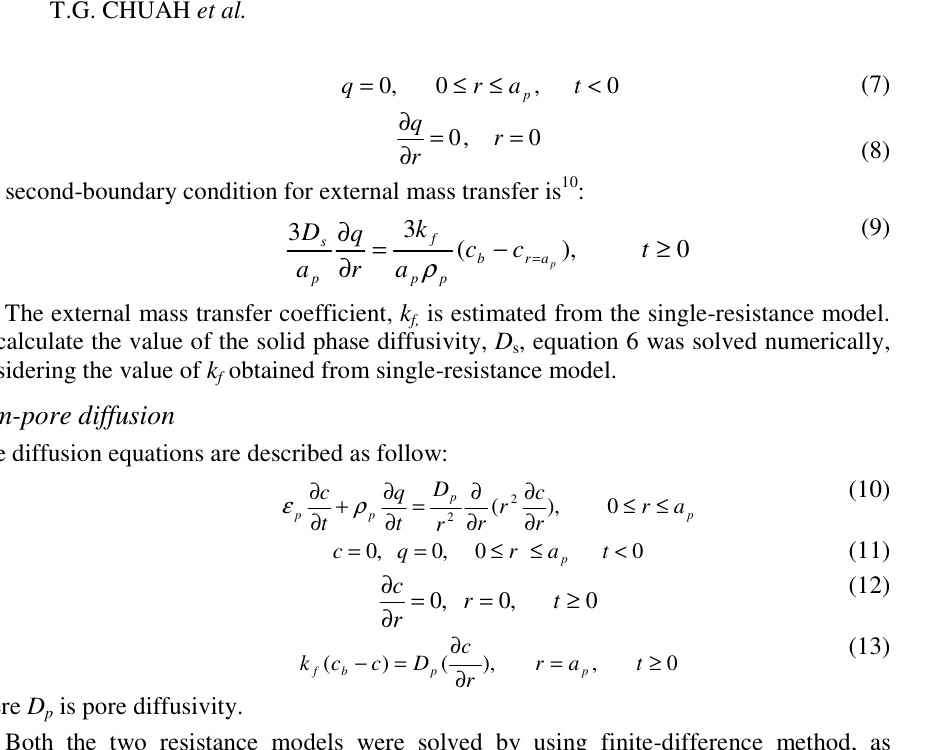
for adsorption of RB 5 and RR E onto PKS- f